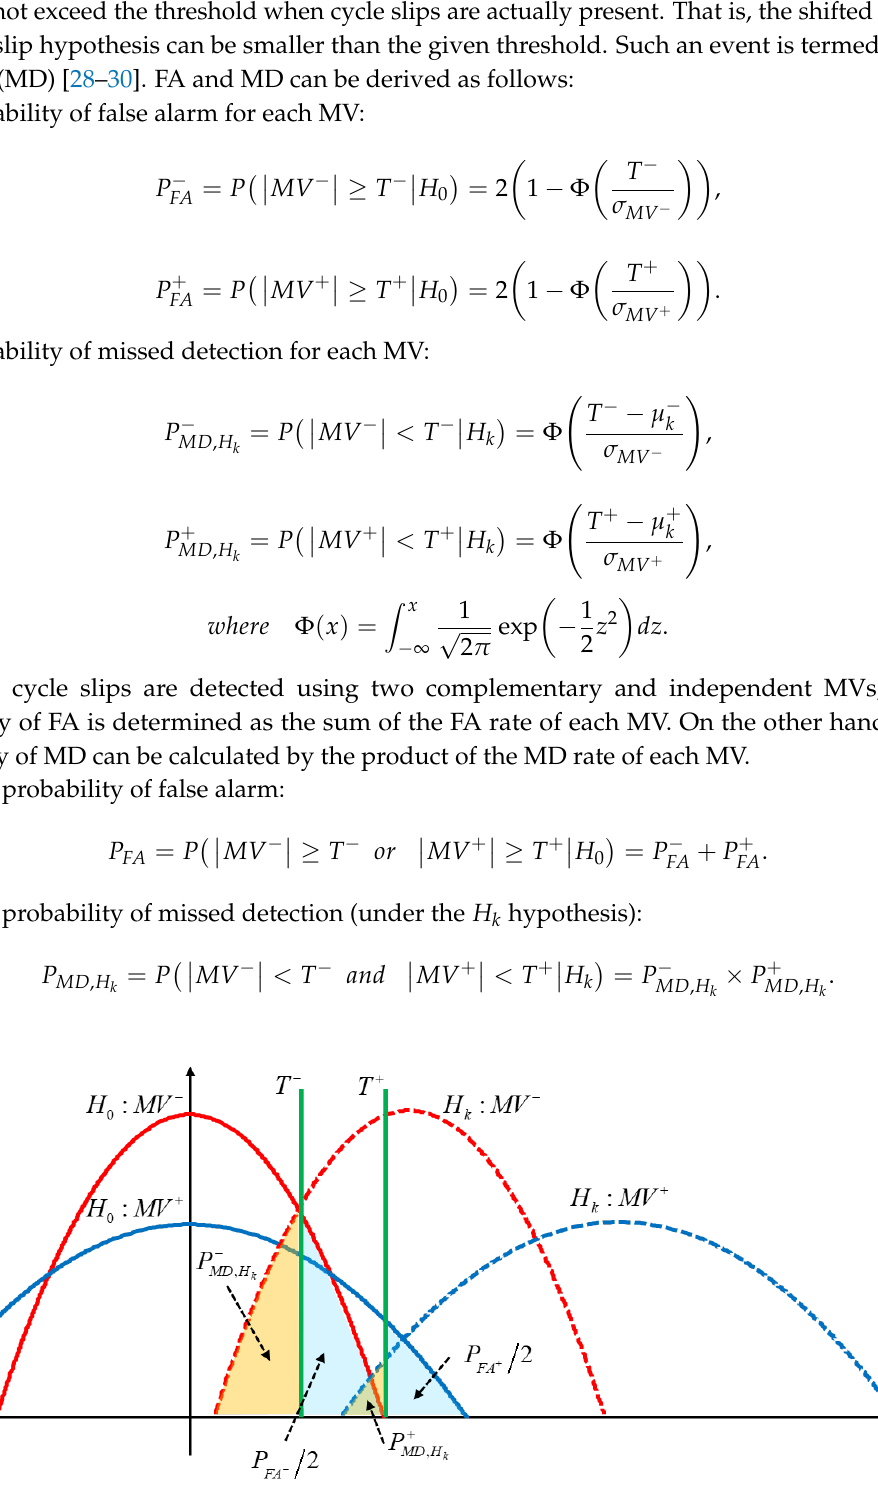
Figure 5. Probability density function of two monitoring values; the region shaded in orange represents the probability of missed detection, and the sky-blue region represents half of the false-alarm probability.